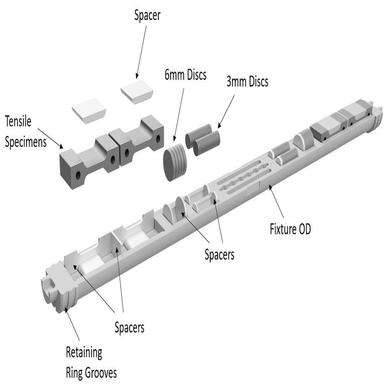
Schematic of the standard capsule fixture with instrumentation. Flux monitors, melt wires, and temperature monitors are included in the standard capsule design.